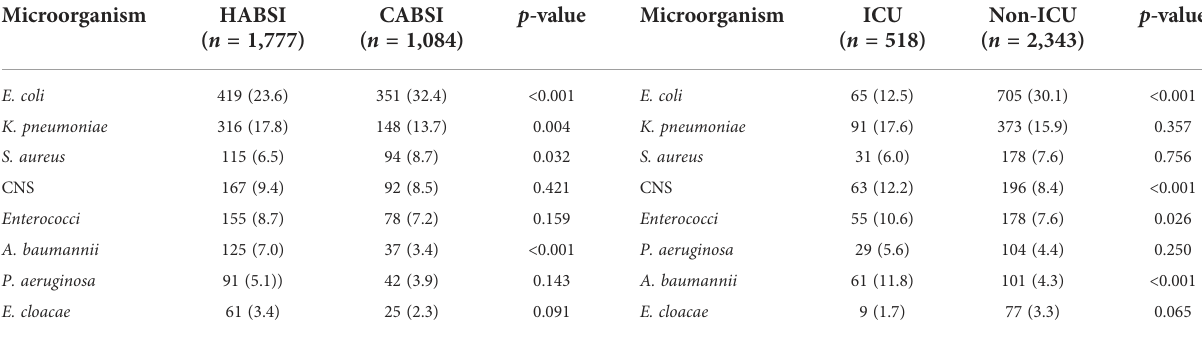
TABLE 4 Distribution of pathogens isolated from hospital-acquired versus community-acquired bloodstream infections and ICU versus non-ICU patients. Microorganism